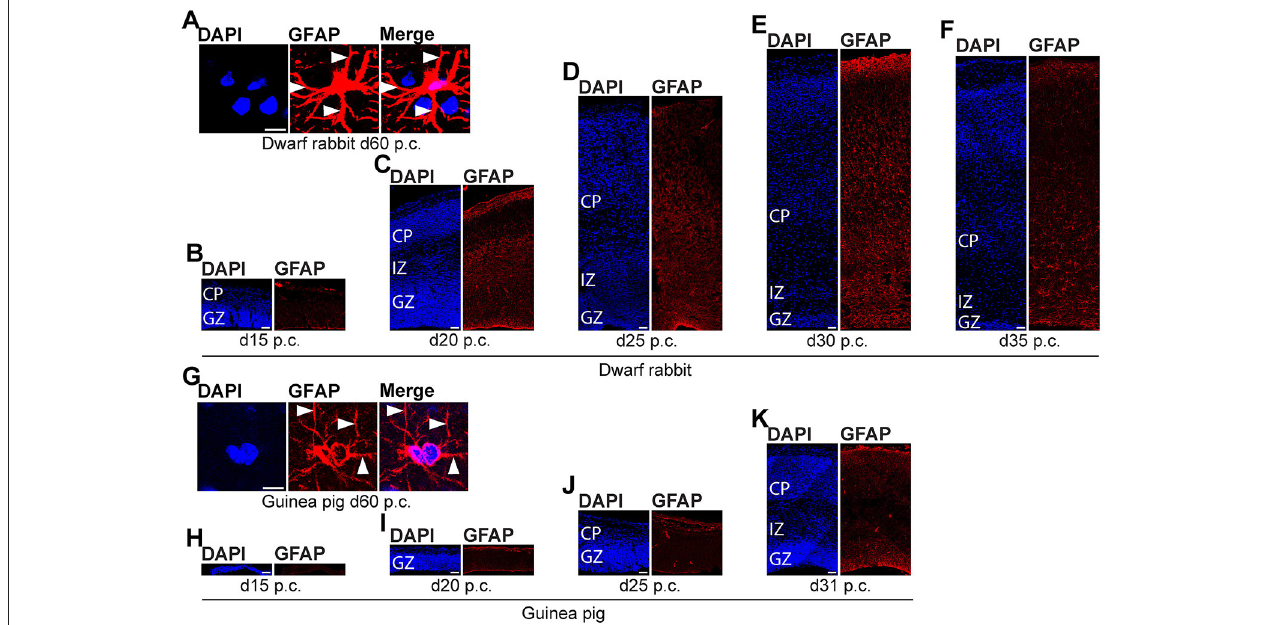
FIGURE 10 | GFAP expression in the developing dwarf rabbit neocortex and guinea pig neocortex. (A–K) Immunofluorescence for GFAP (red) and DAPI staining (blue) on 30- µ m cryosections of day 15–35 post-conception (p.c.) dwarf rabbit (A–F) and d15-31 p.c. guinea pig (G–K) neocortex. Images in (A,G) show GFAP + astrocyte with soma and extending processes (solid arrowhead) in higher magnification of d60 p.c. dwarf rabbit (A) and d60 p.c. guinea pig (F) neocortex. Merge images in (A,G) show combined fluorescence of GFAP and DAPI. CP, cortical plate. GZ, germinal zone. IZ, intermediate zone. Scale bars, 10 µ m (A,G) and 50 µ m (B–F,H–K)